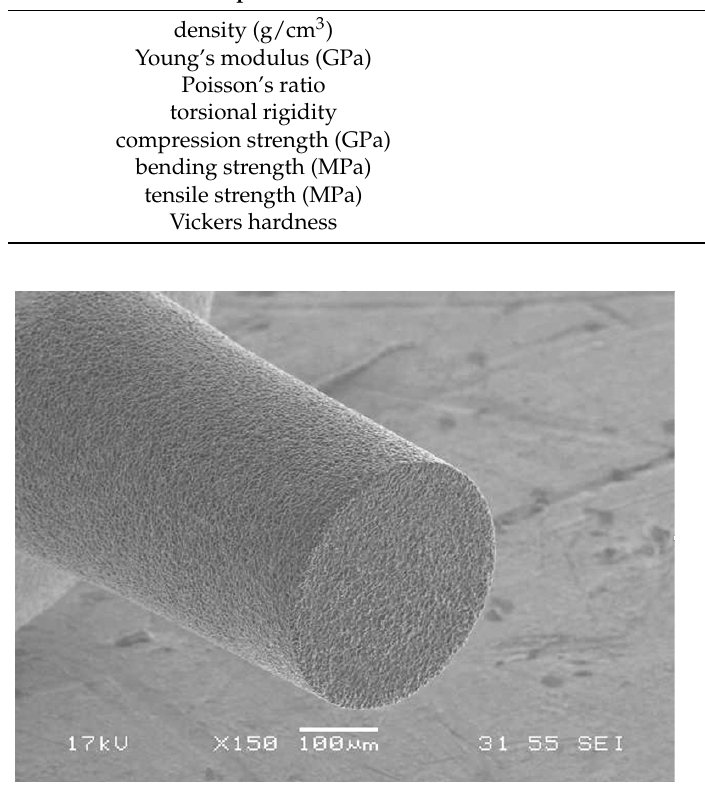
Figure 2. An SEM image of the microtool fabricated via WEDG (100 V, 5600 pF).